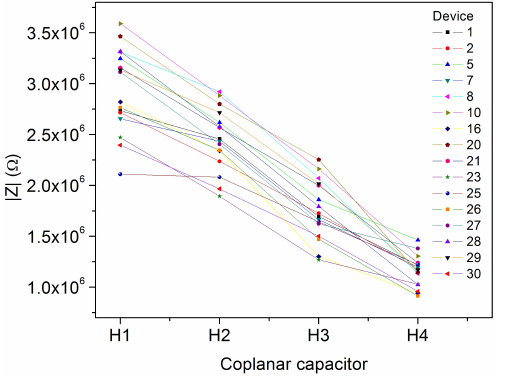
Figure 12. Impedance measured for all the DCA using H1, H2, H3 and H4 at 60,016 Hz. Table 6. Analysis of impedance variation of DCA for all the measurements at 60,016 Hz. Coplanar Electrodes